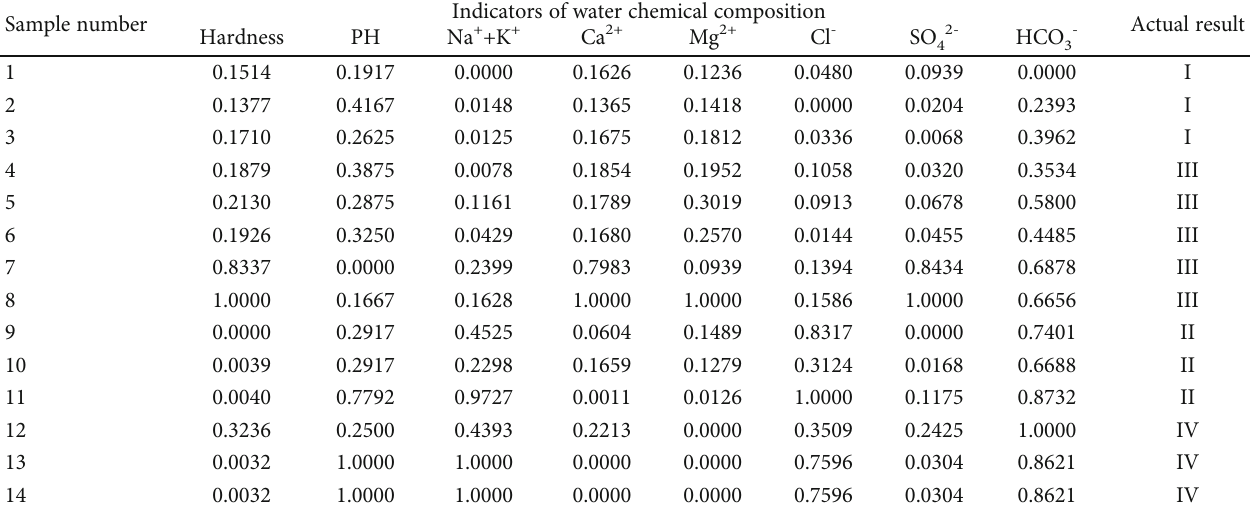
Table 2: Normalized data.